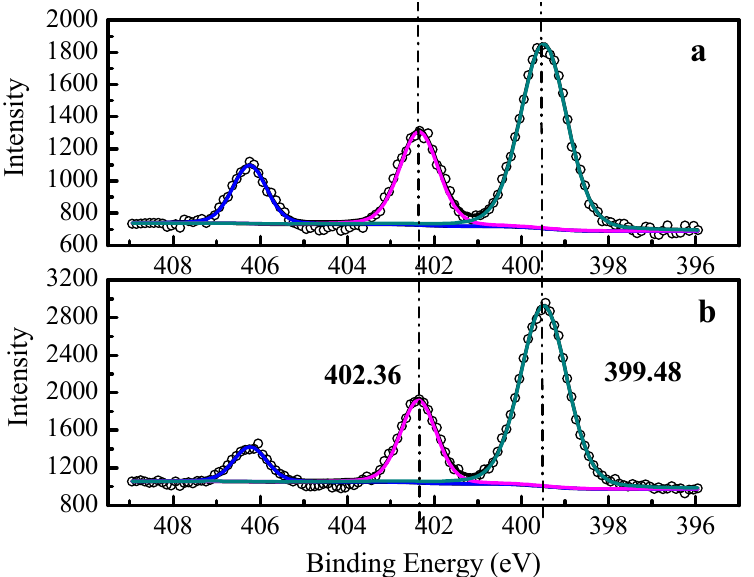
Figure 4. FT-IR spectra of two anion exchange membranes: AEM-Type I and AEM-Type II.